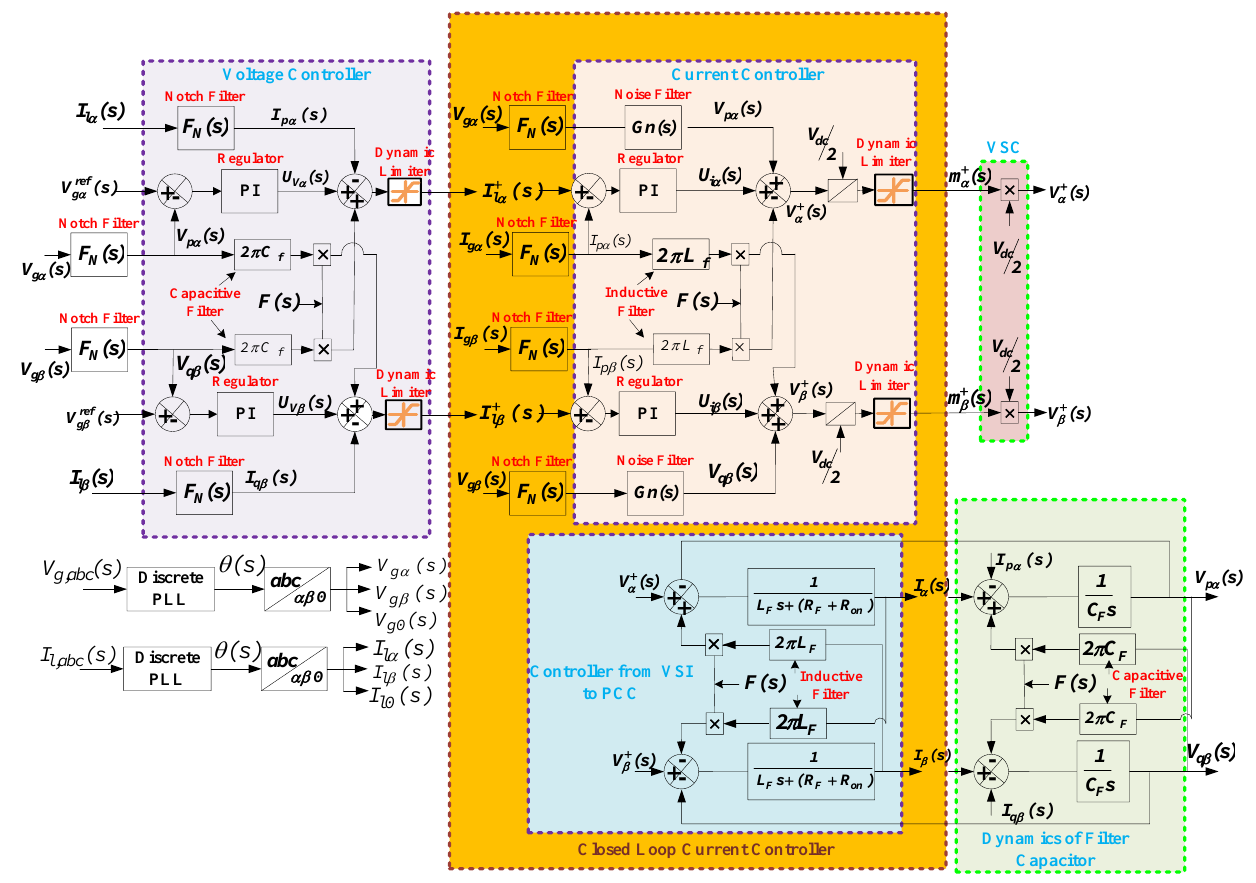
Figure 2. NCVC architecture for 3 𝜑 3W VSI application.